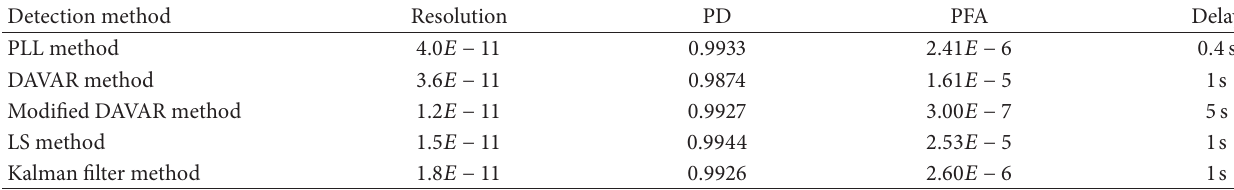
Table 10: Detection performance of frequency jumping for different clock